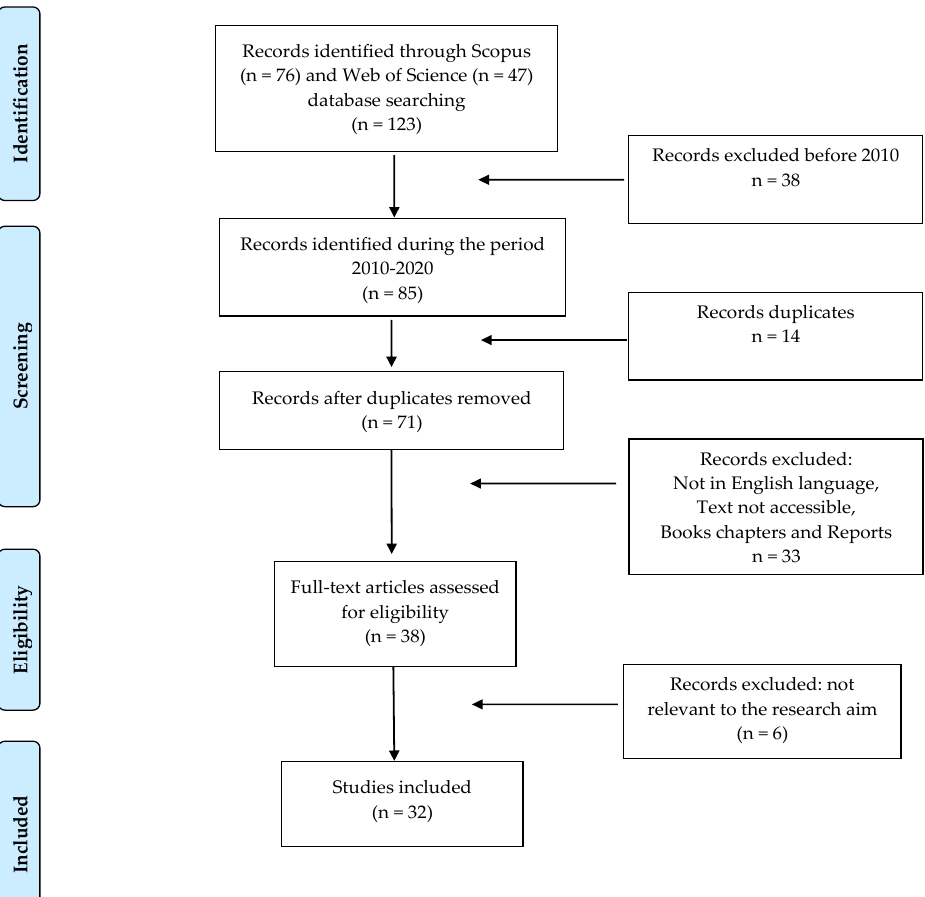
Figure 1. Flow chart diagram visualizing the database literature searching procedure. The exclusion criteria are indicated. (Source: our elaboration.)